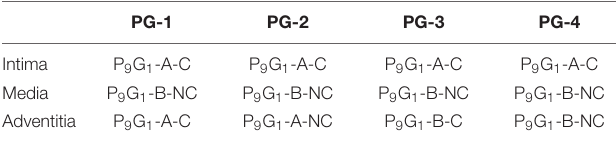
TABLE 4 | PVA/gelatin (PG) compositions used in the four iterations of the PVA/gelatin FE model. PG-1 PG-2 PG-3 PG-4 Intima